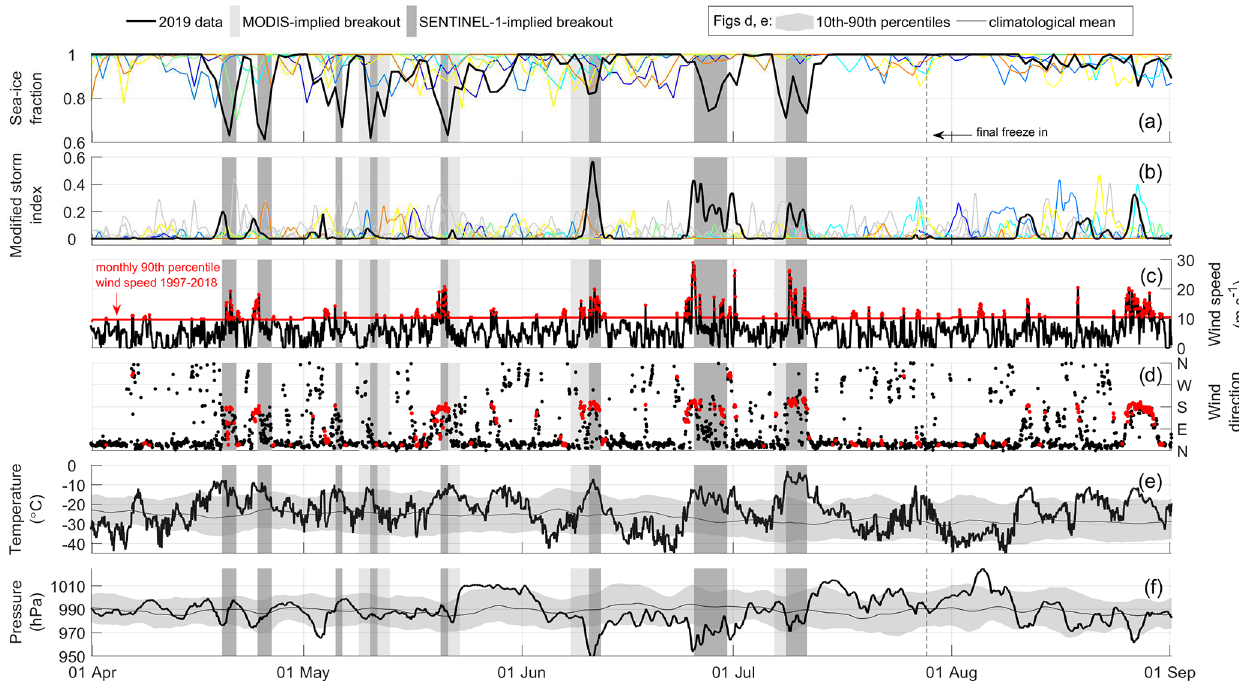
Figure 3. (a) Sea-ice fractional cover within the red bounding box shown in Fig. 1a for the years 2013–2019: black: 2019; coloured lines: 2013–2018. (b) Modified storm index (MSI) constructed from temperature and mean sea-level pressure anomalies for the years 2002– 2019: black and coloured lines as for (a) ; grey: years for which sea-ice fraction data are not available (2002–2012). (c) The 2019 wind speed: red line: the monthly 90th percentile wind speed (data from 1997–2018); red markers: wind speeds greater than the climatological 90th percentile. (d) The 2019 wind direction: red markers: wind speeds greater than the climatological 90th percentile. (e, f) Surface air tem- perature and MSLP, respectively. The 10th–90th percentiles and climatological mean include temperature and MSLP data from 1997–2018 and 2002–2018, respectively. Percentiles have been smoothed using a 3d window. Vertical shading throughout all subplots identifies times when satellite products indicate fast-ice break-out events (see Sect.